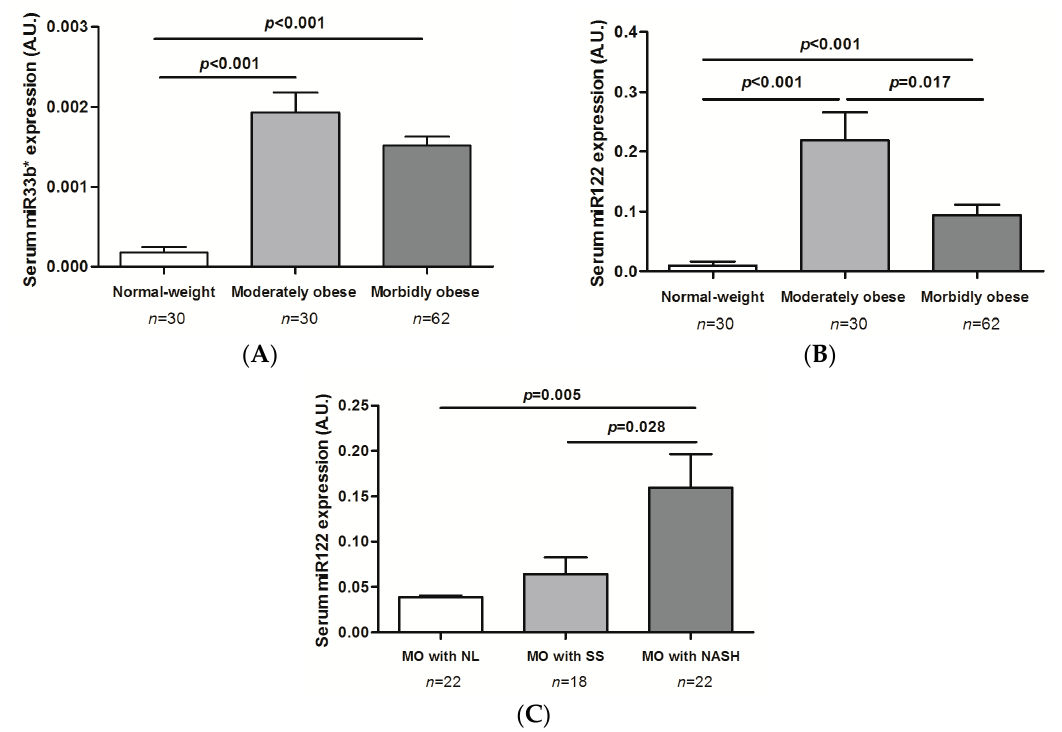
Figure 5. Circulating miR33b* ( A ) and miR122 ( B ) expression depending on the degree of obesity. ( C ) Differential circulating miR122 expression in morbidly obese patients according to liver pathology. MO with NL, morbidly obese patients with normal liver; MO with SS, morbidly obese patients with simple steatosis; MO with NASH, morbidly obese patients with steatohepatitis; AU, arbitrary units. Differences between groups were calculated using one-way ANOVA. Results are shown as the mean ± SEM. p < 0.05 is considered statistically significant.